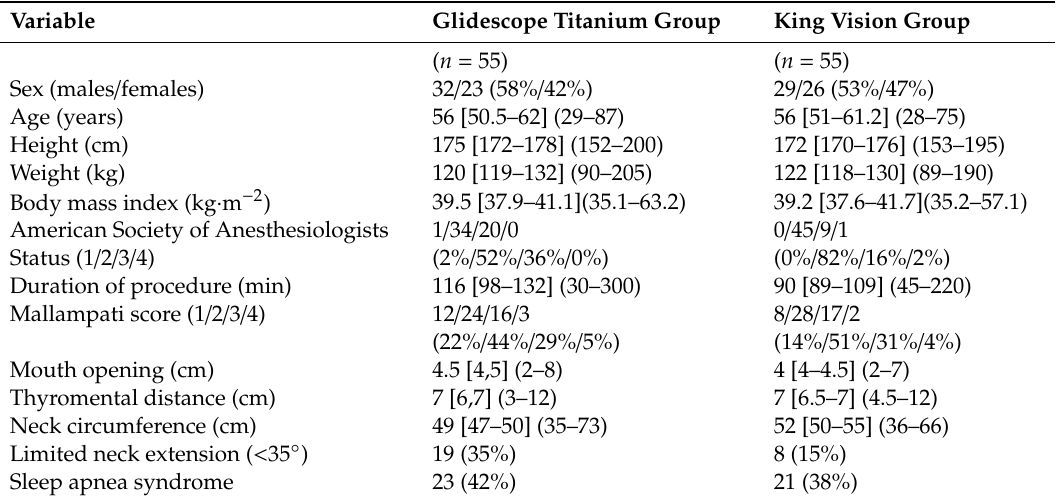
Table 1. Demographic parameters and preoperative airway assessment